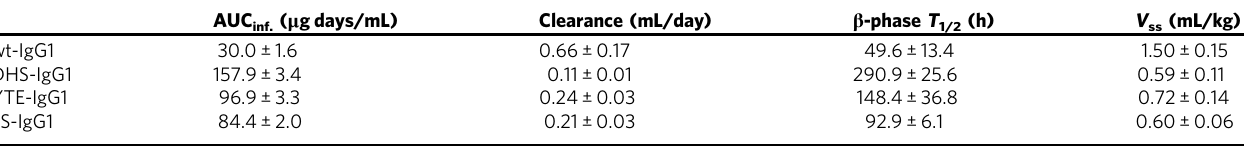
Table 2 Pharmacokinetic parameters for hemizygotic Tg276 hFcRn transgenic mice AUC inf. ( μ g